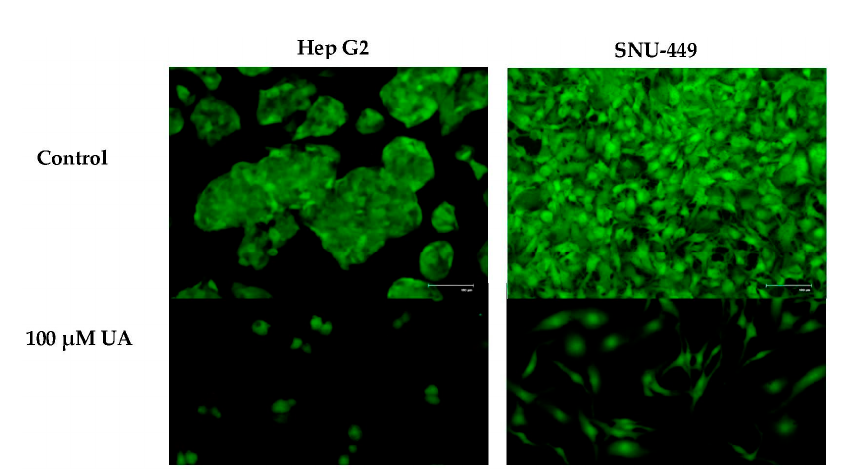
Figure 1. Morphological changes caused by UA in Hep G2 and SNU-449